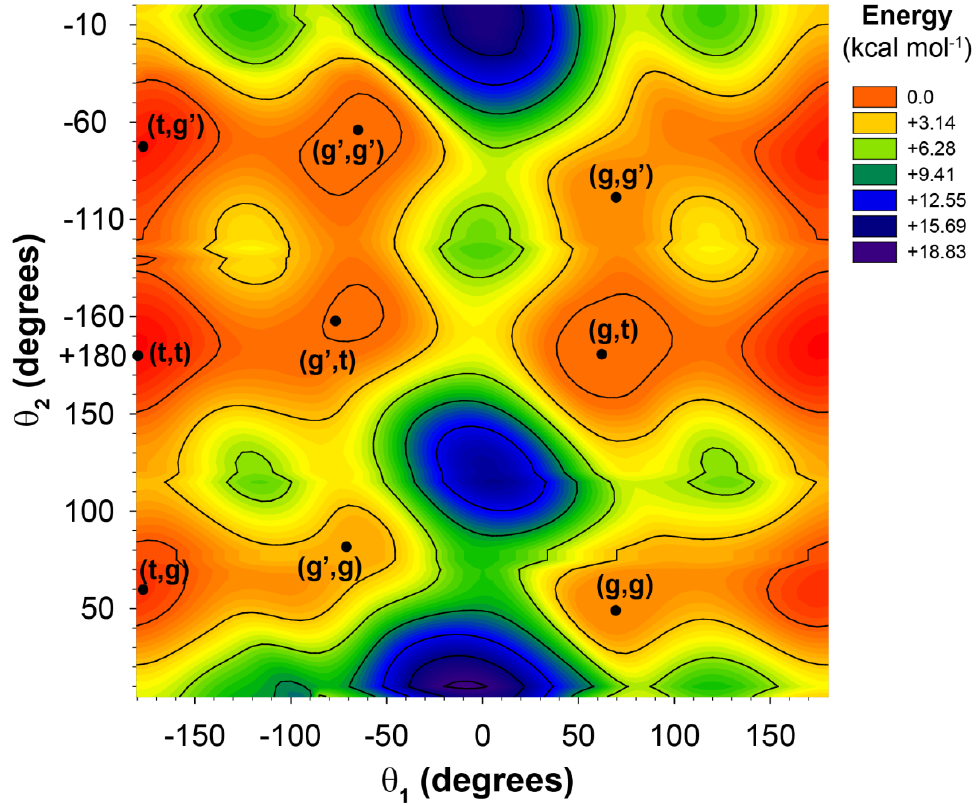
Figure 2. The potential energy surface for the 2-butylhexanoic acid model cluster as a function of the θ and θ dihedral 1 2